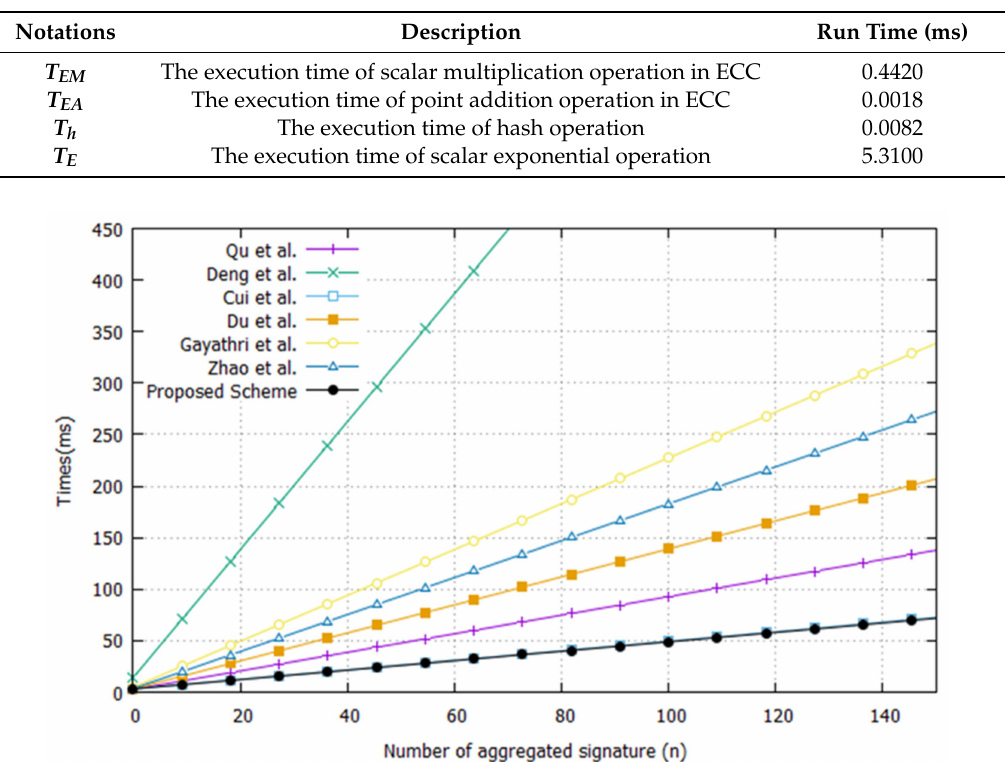
Figure 9. Comparison of execution time between proposed and existing